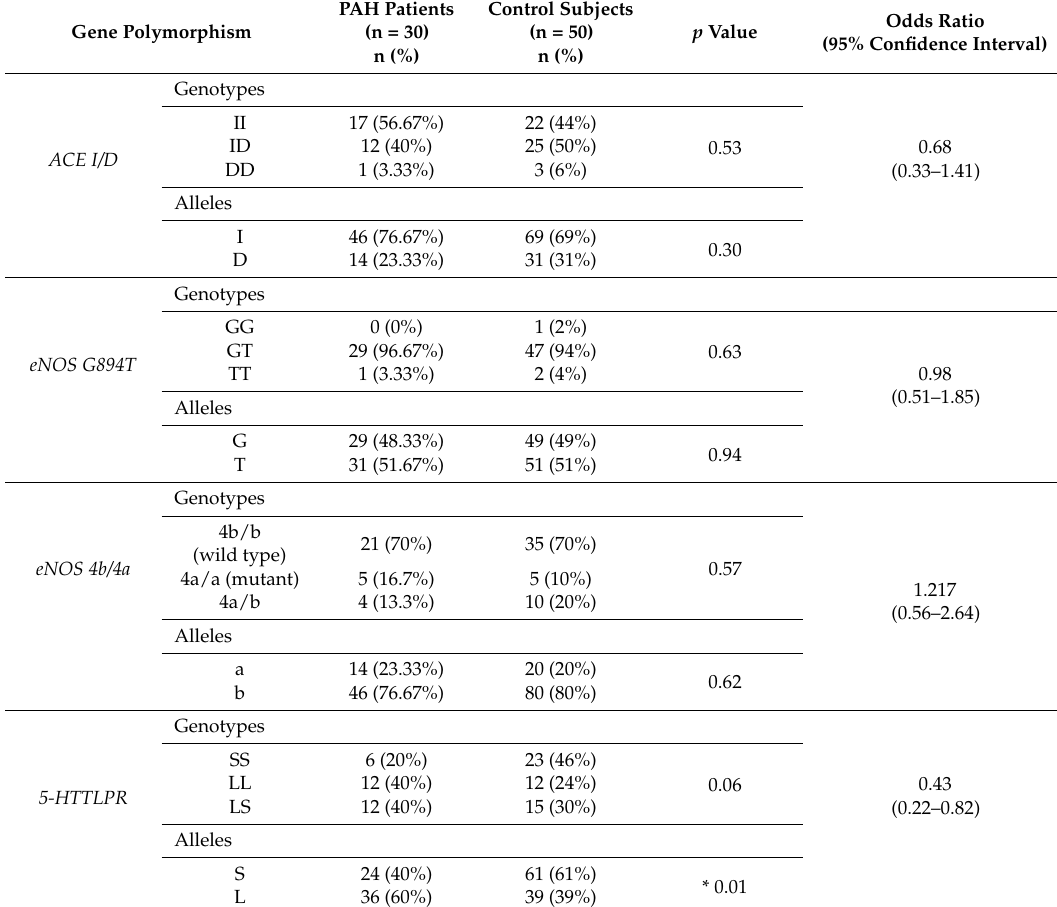
Table 3. Distribution of genotypes and allele frequencies of each gene polymorphisms between PAH patients and control